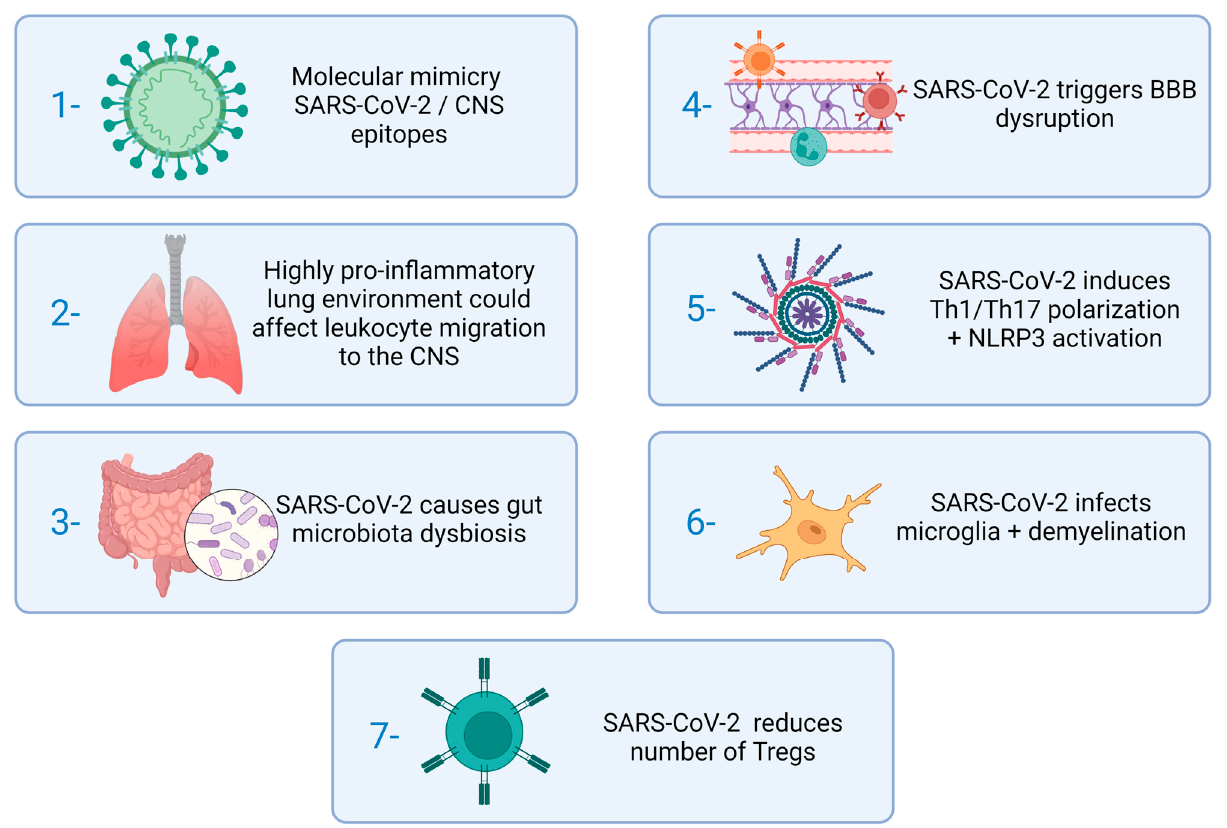
Figure 4. Stages of MS immunopathogenesis which could be affected by SARS-CoV-2. Source: Created with Biorender.com